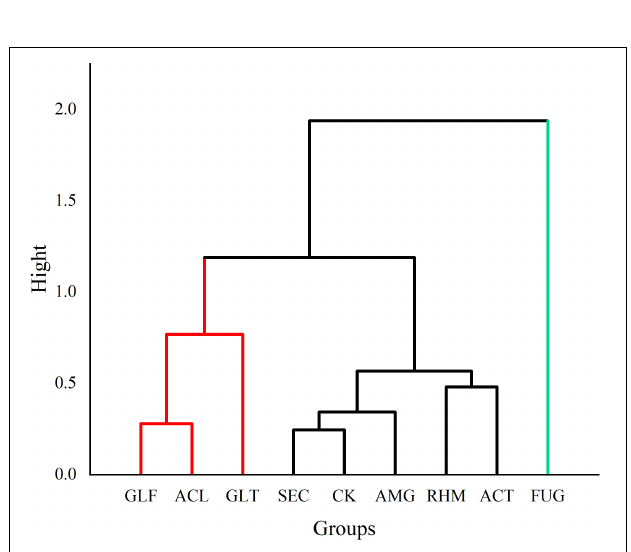
FIGURE 4 | Score chart of PCA of different AMF treatment groups (phenolic